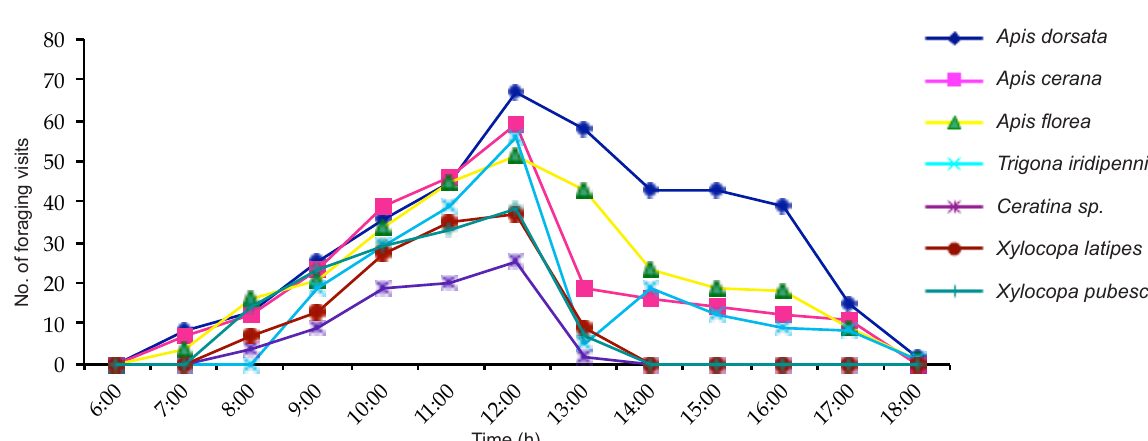
Figure 1. Hourly foraging activity of bees on Boswellia ovalifoliolata